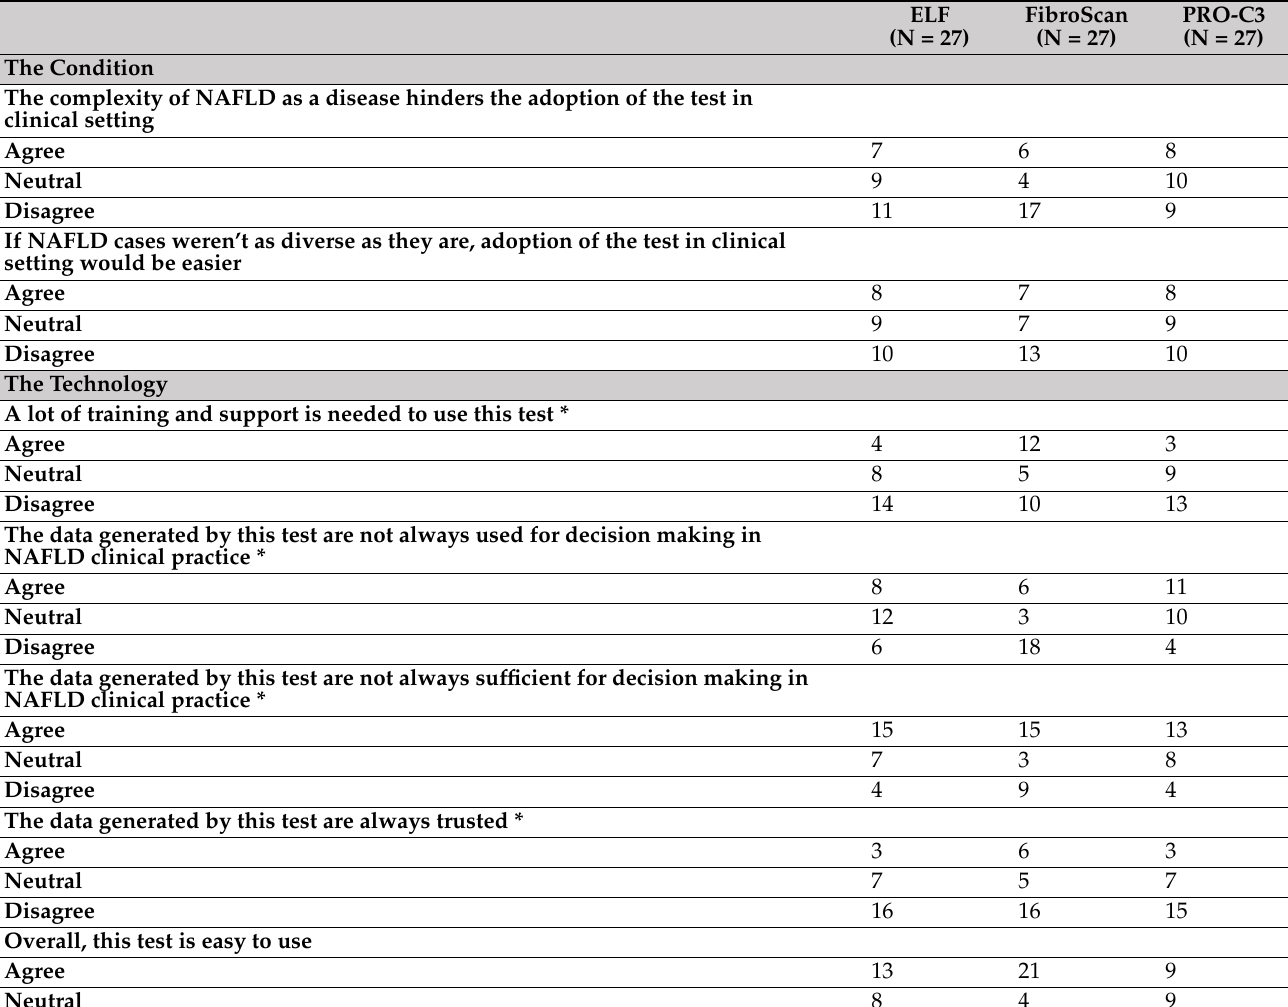
Table 3. Results per items of “The Condition” and “The Technology” domains of the Non-adoption, Abandonment, Scale-up, Spread, and Sustainability (NASSS) framework as reported by responders.